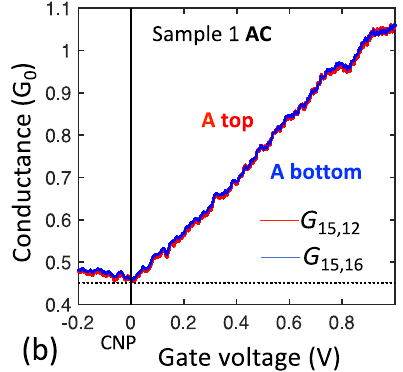
Fig. 6 | Demonstration of 1D edge state transport. a 4-point conductances of sample 2, Seg. B measured from the top ( G 15,23 ; red) and the bottom ( G 15,67 ; blue); b 3-point conductances ofsample1, Seg. B measured from the top( G 15,12 ; red) and the bottom (G 15,16 ; blue). The perfect overlap shown in the two cases is consistent